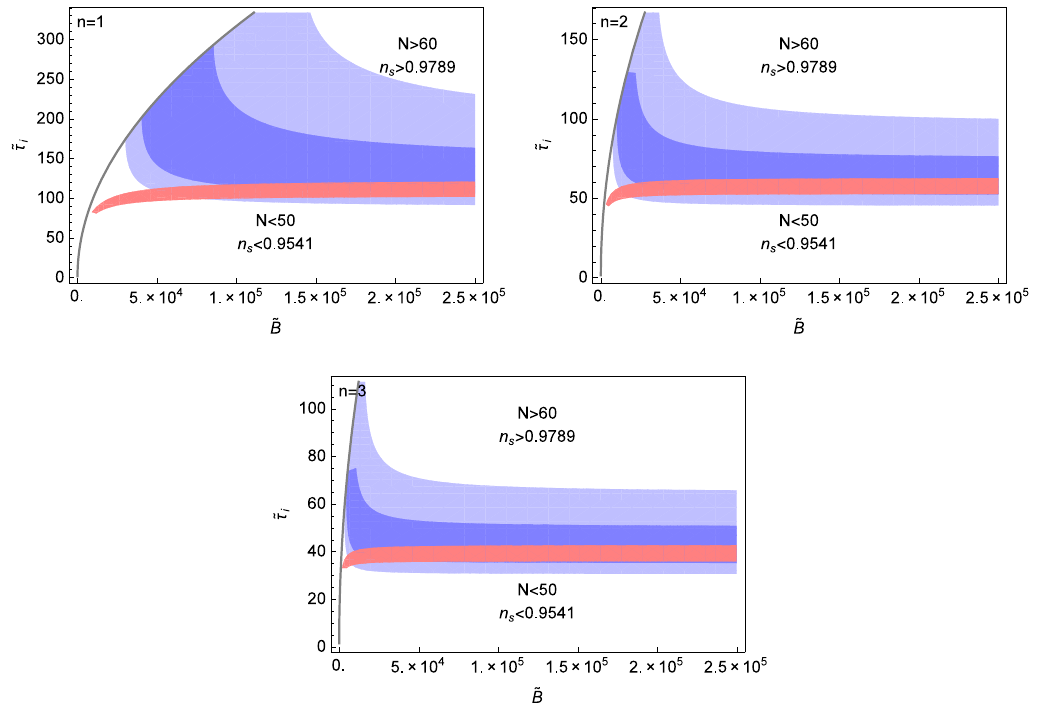
Figure 3 . We evaluate n s and N on ( ~ B; ~ (cid:28) i )-plane for A > 0 when the in(cid:13)aton rolls towards the minimum ~ (cid:28) = 1 ( (cid:28) = A ). Three panels correspond to di(cid:11)erent values of n . The black solid line 2 2 expresses ~ (cid:28) i = ~ (cid:28) 0 (~ (cid:28) 0 represents the hilltop) and the region below this line is for the in(cid:13)aton rolling towards the minimum ~ (cid:28) = 1 (the other region corresponds to the in(cid:13)aton rolling towards ~ (cid:28) ! 1 ). 2 does not a(cid:11)ect the accuracy of the estimation of N by more than a few percent for the parameter range discussed in this